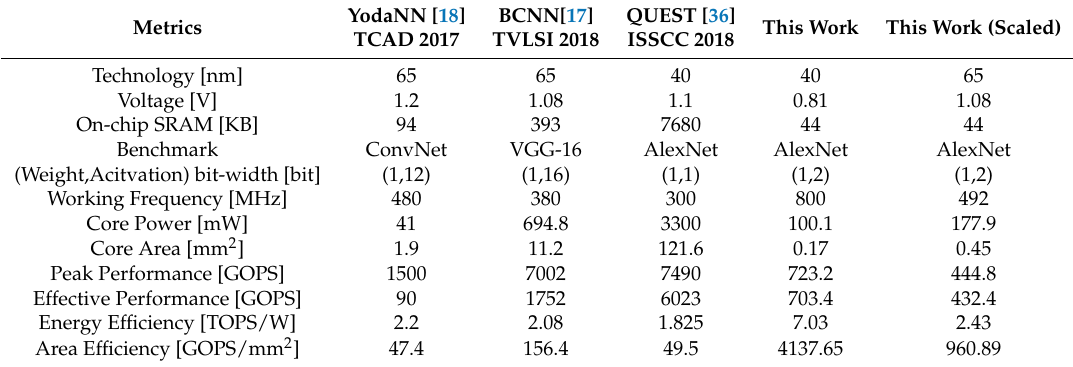
Table 5. Comparison with previous